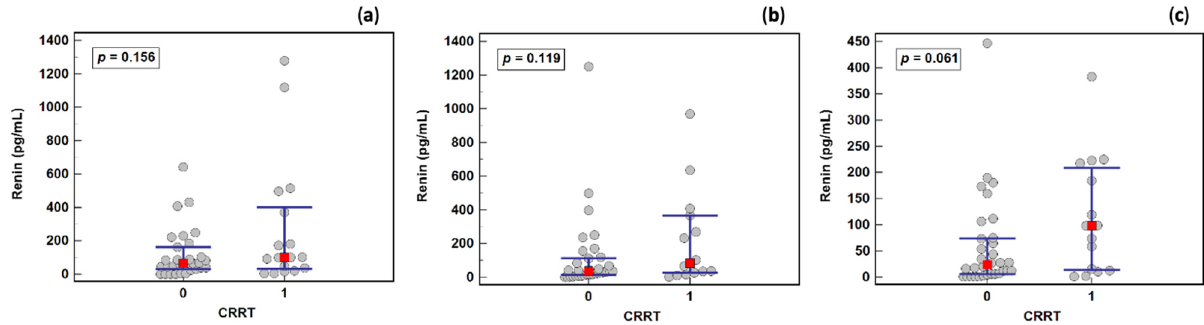
Figure 2. The effect of continuous renal replacement therapy (CRRT) on renin concentration: ( a ) on the first study day; ( b ) the third study day; ( c ) in the fifth study day. Notes: Data were analyzed using Mann–Whitney U tests, and are presented as medians (red squares) with interquartile ranges (blue whiskers).